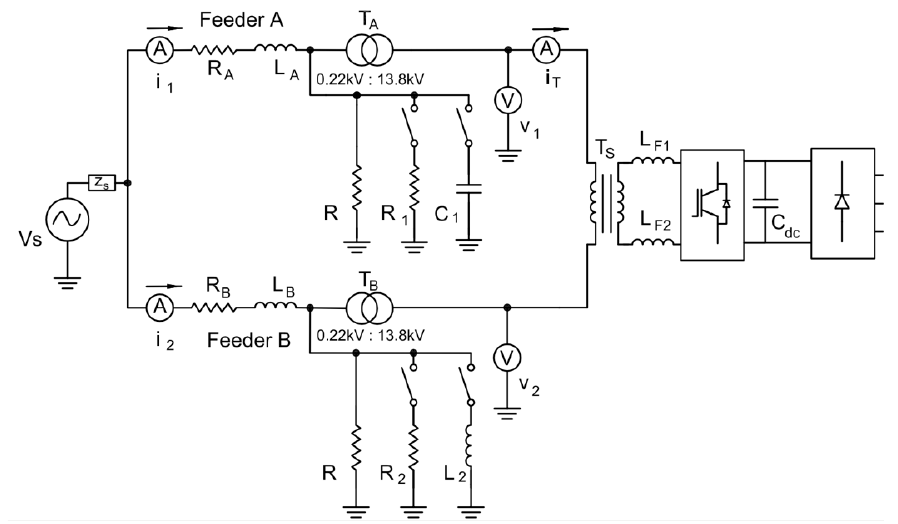
Figure 11. Single-line laboratory test setup diagram.